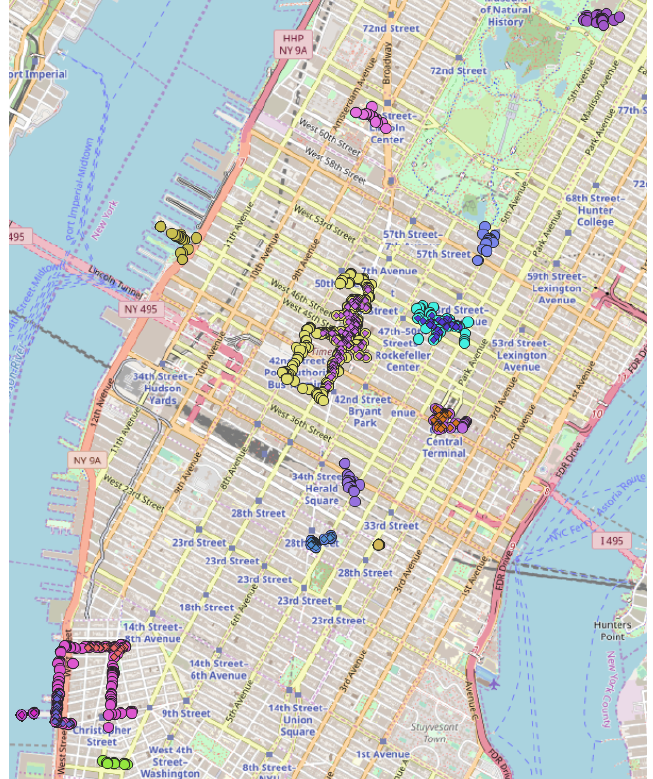
Figure 10. Experimental data samples and clustering